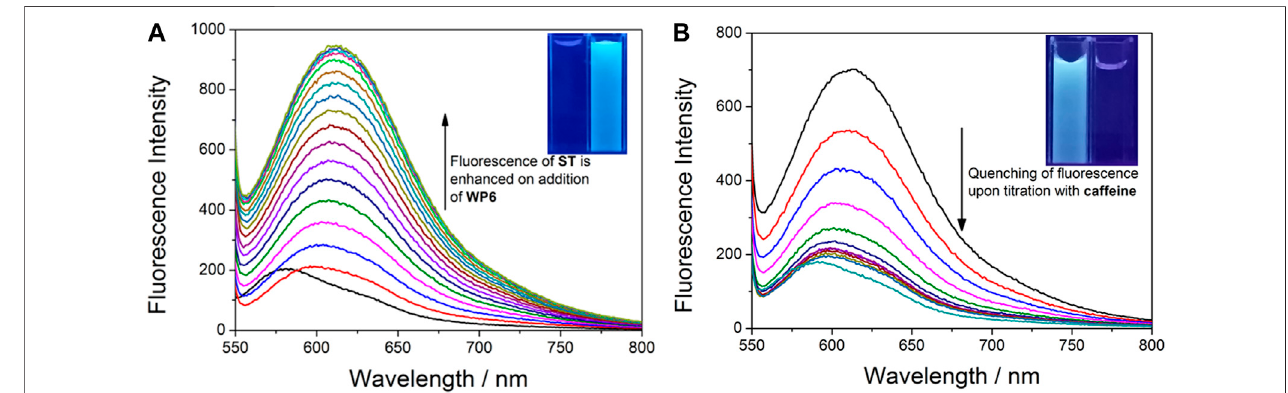
FIGURE 3 | (A) Changes of the fl uorescence intensity in ST (0.02 mM) upon the titration of WP6 (0 – 25 equiv.) in PBS ( λ ex (cid:1) 523 nm, λ em (cid:1) 584 nm, pH (cid:1) 7.2). The inserted photo exhibits an enhancement in fl uorescence in water under excitation at 365 nm via the UV lamp at 298 K. (B) Fluorescence titration for the competitive displacement of ST (0.02 mM) from WP6 (0.3 mM) using caffeine (0 – 150 equiv.) in PBS at pH 7.2 ( λ ex (cid:1) 523 nm, λ em (cid:1) 584 nm). The inserted photo exhibits the corresponding fl uorescence quenching in water under excitation at 365 nm via the UV lamp at 298 K.